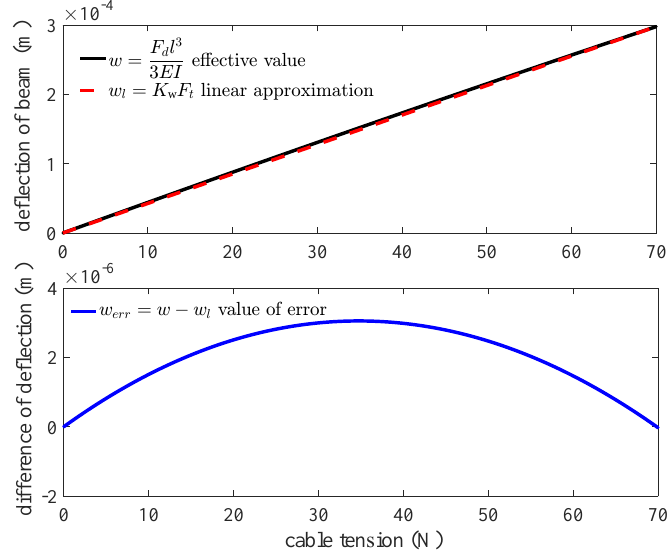
Figure 6. The deflection of beam w changes with the cable tension F t in Equation (3) with a linear approximation w l in the top panel and the difference of them w err in the bottom